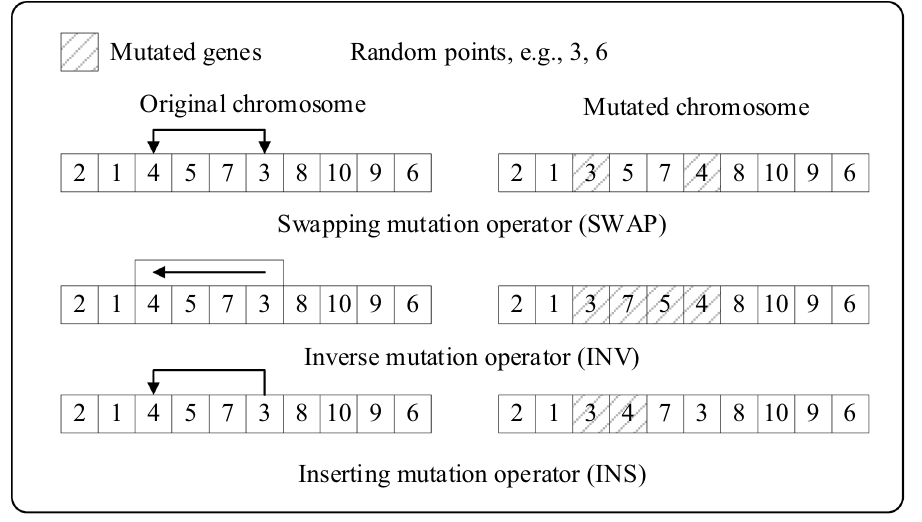
Figure 6. Mutation